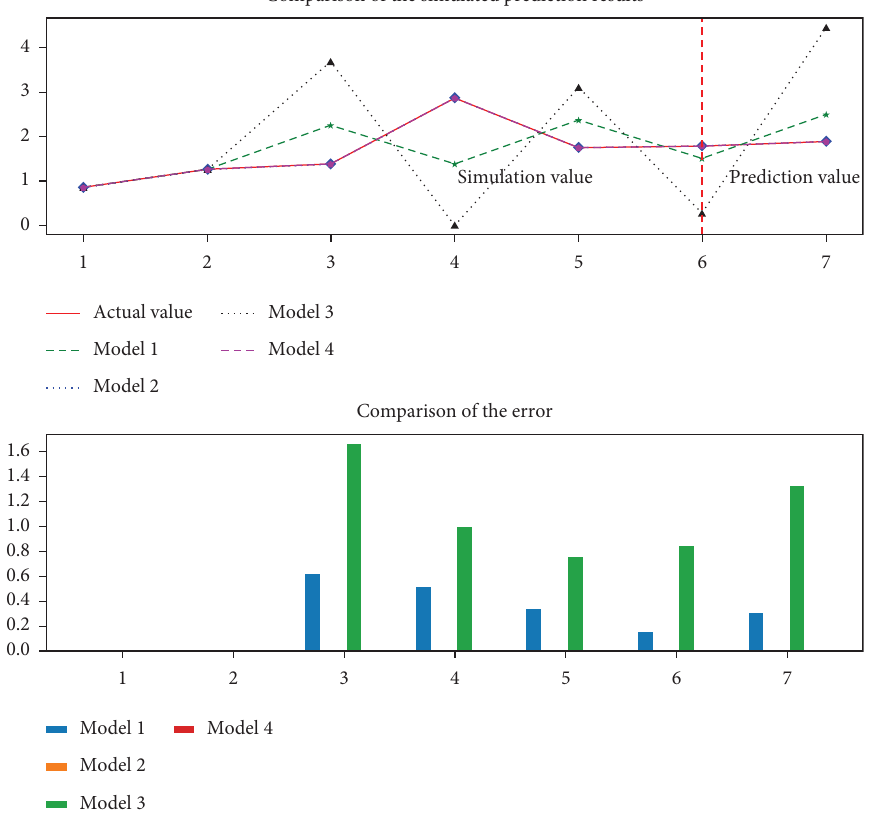
Figure 3: Schematic diagram of the predicted results for stochastic oscillation sequence X